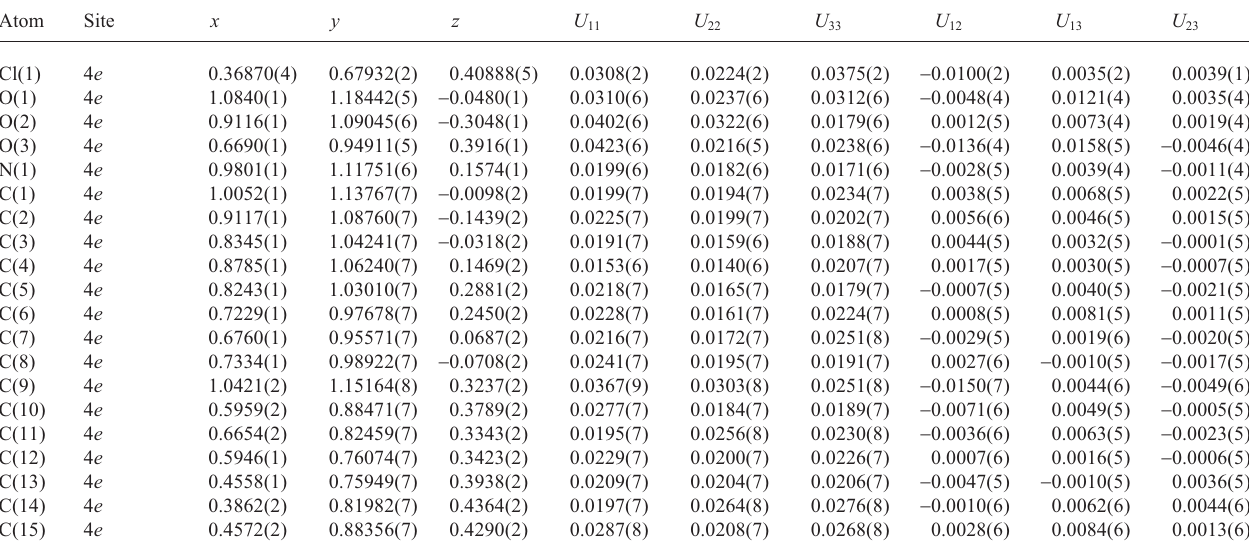
Table 3. Atomic coordinates and displacement parameters (in Å 2 )